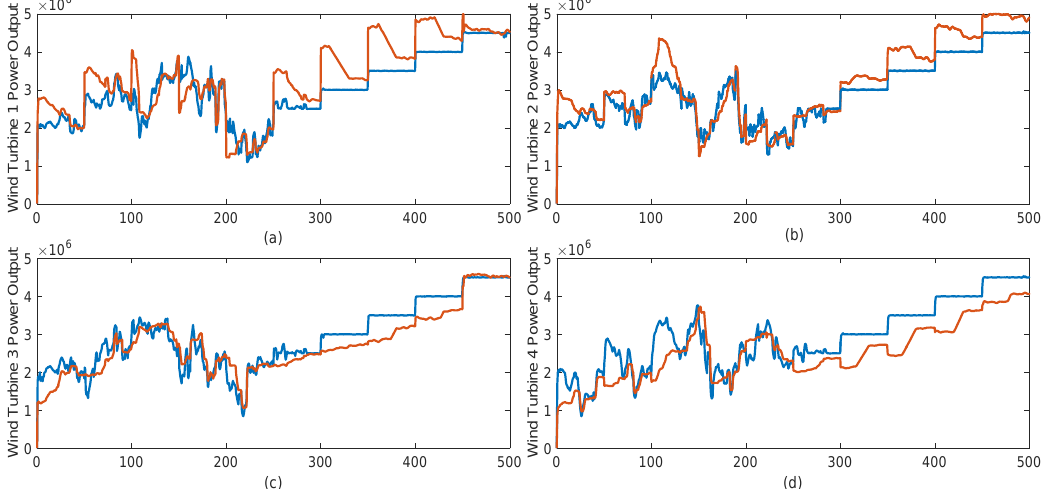
Figure 8. Four-units cluster robustness test—comparison between the proposed strategy and the conventional strategy, sub-figures a, b, c, d are the active power output comparison between the proposed strategy and conventional strategy for wind turbine 1, 2, 3, 4